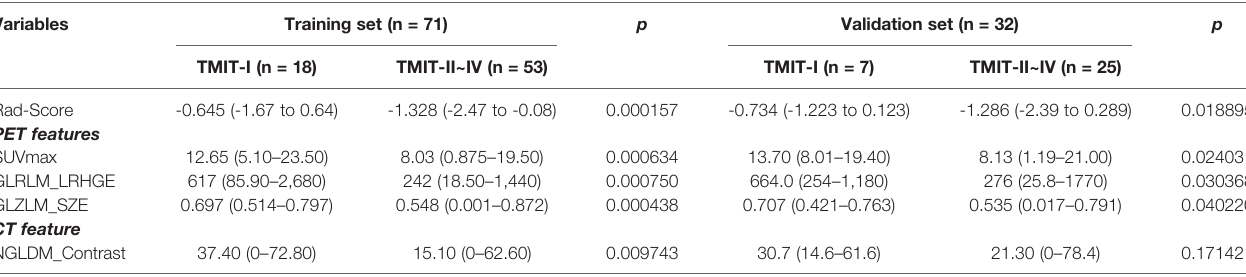
TABLE 2 | The differences of four selected radiomic features and the calculated rad-score between TMITs. Variables